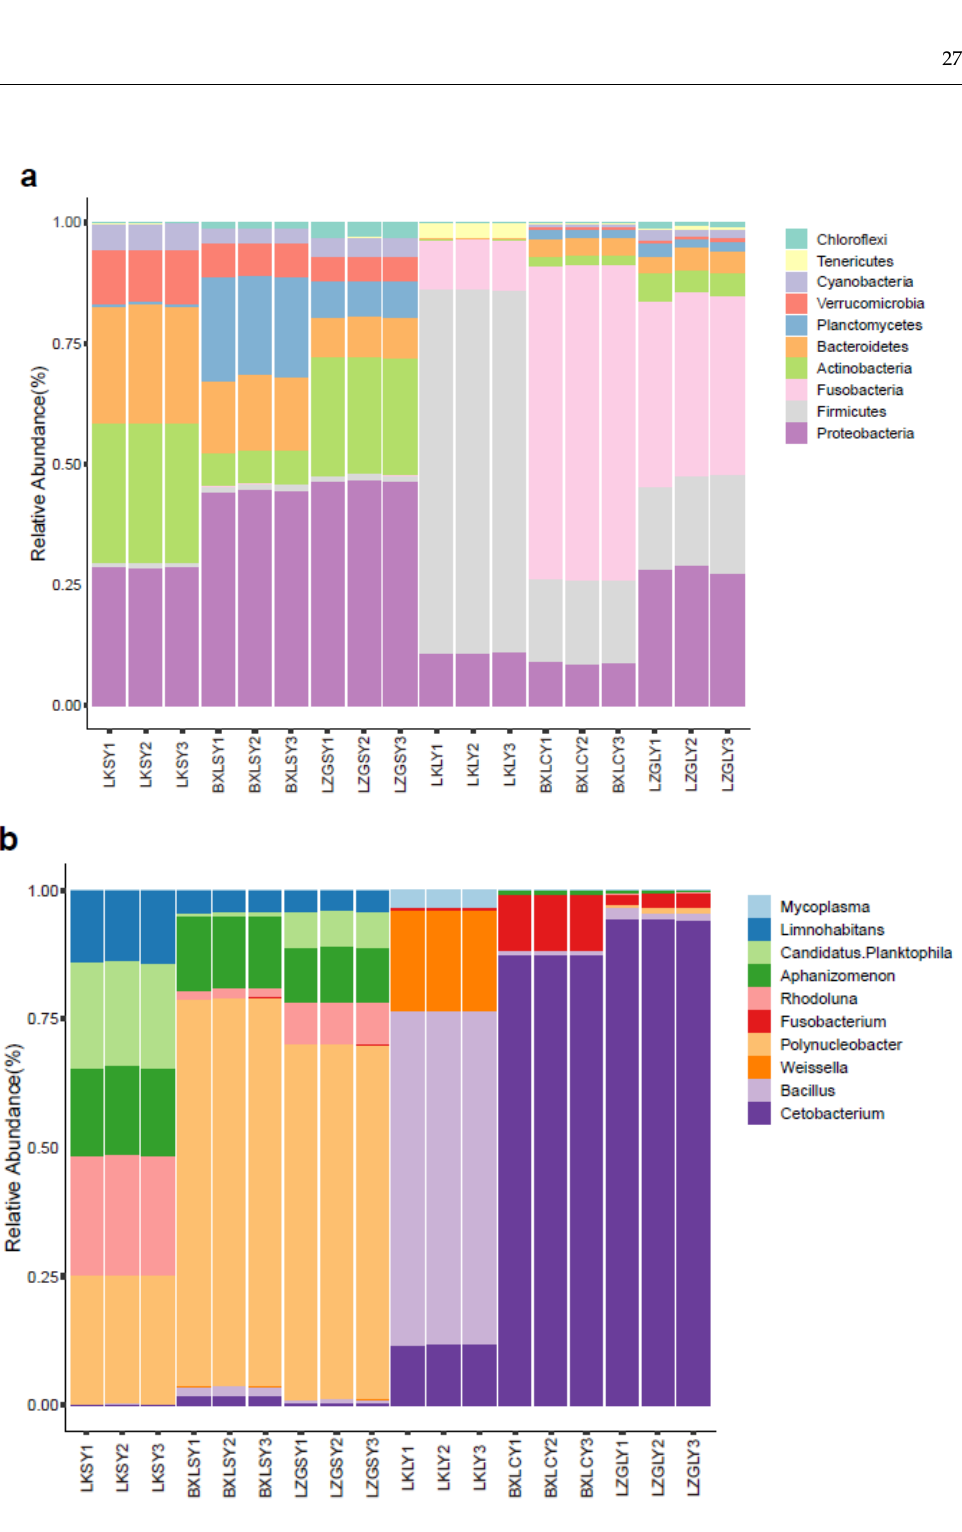
Figure 1. The profile of bacterial communities in different samples. ( a ) phylum level; ( b ) genus level. LK, BXL, and LZG were the abbreviation of the three fish farms. Water samples from LK farm were LKSY1, LKSY2 and LKSY3 while LKLY1, LKLY2 and LKLY3 were the name of fish gut content samples from LK fish farm. Likewise, BXLSY1-3 and LZGSY1-3 were water samples from BXL and LZG fish farm, respectively. BXLCY1-3 and LZGLY 1-3 were fish gut contents from BXL and LZG fish farm, respectively.